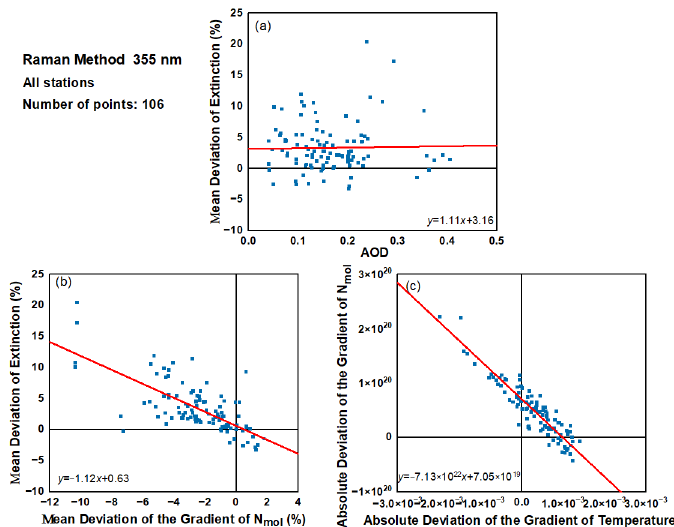
Figure 8. ( a ) The relationship between the mean relative deviation of extinction and aerosol load; ( b ) The relationship between the mean relative deviation of extinction and the mean relative deviation of the gradient of molecular number density; ( c ) The relationship between the mean absolute deviation of the molecular number density gradient and the mean absolute deviation of the temperature gradient. The red lines shown in the subfigure indicate the linear fit curve, of which the equations are also reported, being x and y the variables of the axes.